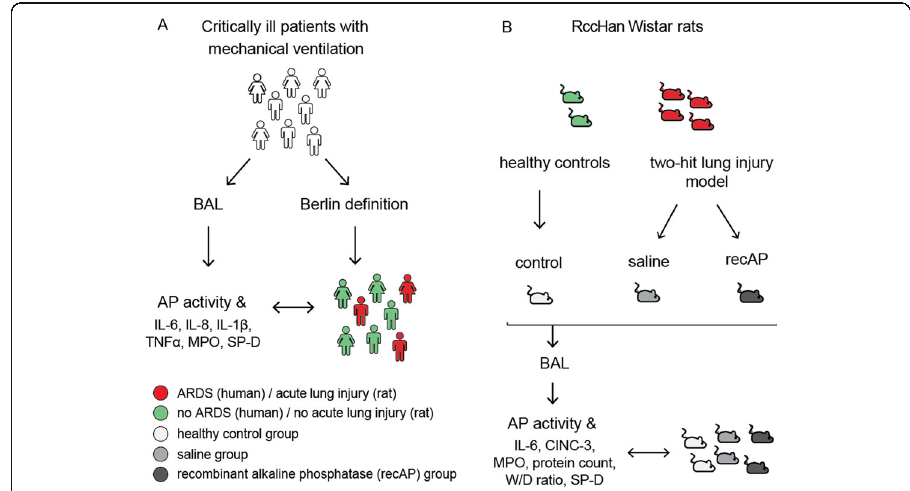
Fig. 1 Schematic presentation of methodology for the clinical and preclinical study. a Clinical study. b Preclinical study. Abbreviations: ARDS, acute respiratory distress syndrome; AP, alkaline phosphatase; BAL, bronchoalveolar lavage; recAP, recombinant alkaline phosphatase; IL, interleukin; MPO, myeloperoxidase; SP- D, surfactant protein D; TNF, tumor necrosis factor; W/D ratio, lung wet-to-dry